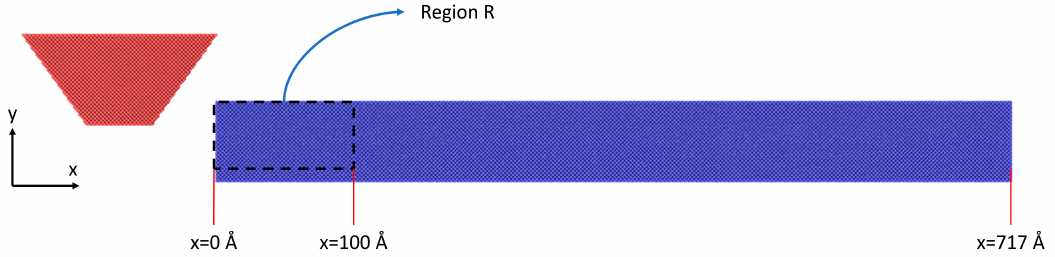
Figure 9. Location of region R.